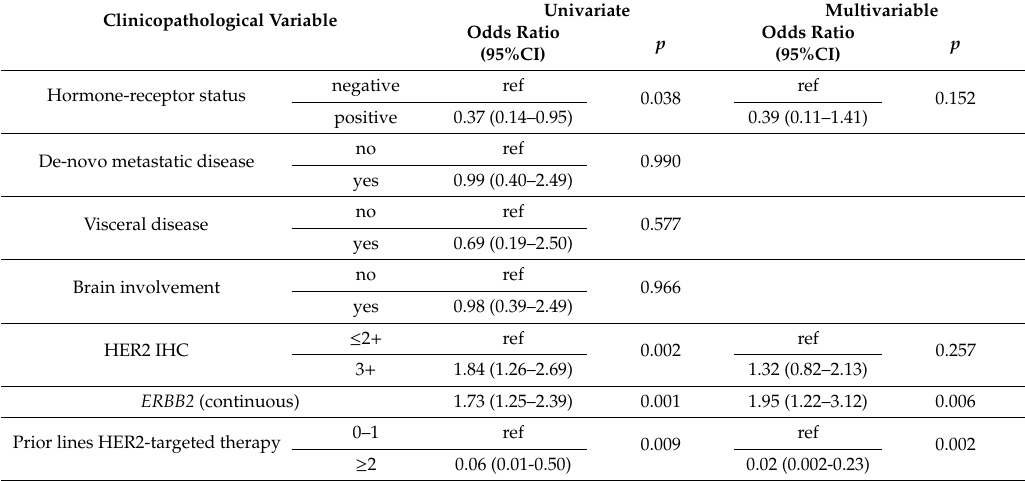
Table 2. Univariable and multivariable logistic regression analyses of overall